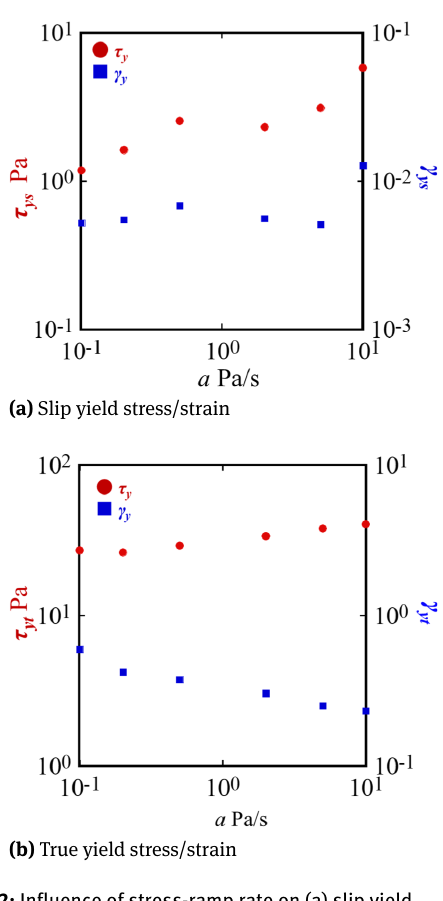
the start of the experiment to a certain stress τ max was used to be fitted by the Maxwell model. The high end stress of this fitting range τ max was selected from 0.5 Pa to the yield stress and the Maxwell model fitting was applied for each stress range. The correlation coefficient R 2 between the Maxwell model and experimental data was calculated to examine the accuracy of the Maxwell model approximation. of the maximum applied stress in the fitting range τ max . The corresponding stress-strain curves are also shown in the figure. The horizontal axis τ max means that the range of fitting is extended from zero to τ max , which is related to the correlation coefficient R 2 on the first vertical axis. Similarly, The horizontal axis τ refers to the stress in the vertical axis. In other words, in Figure 13(a), the value of R 2 at τ max = 0.3 Pa shows the result of the Maxwell model fitting for the range from zero to 0.3 Pa. In Figure 13(a), the correlation coefficient is approximately 1 for a maximum applied stress between 0.5 Pa and 1.9 Pa, which implies that the Maxwell model can fit the strain behavior